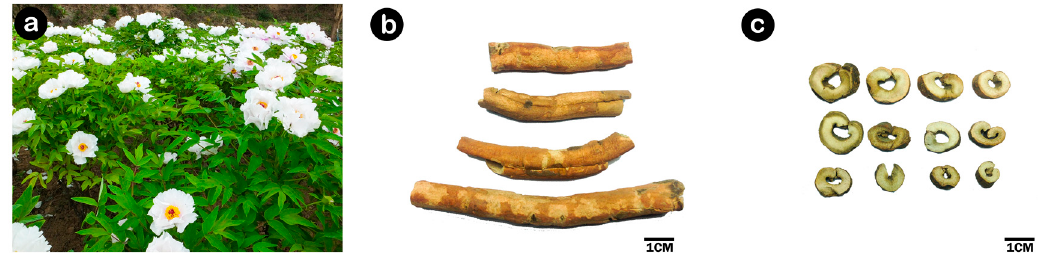
Figure 1. ( a ) Plants of P. suffruticosa ; ( b ) Crude drug of Guadanpi ; ( c ) Decoction pieces of Cortex Moutan (CM).